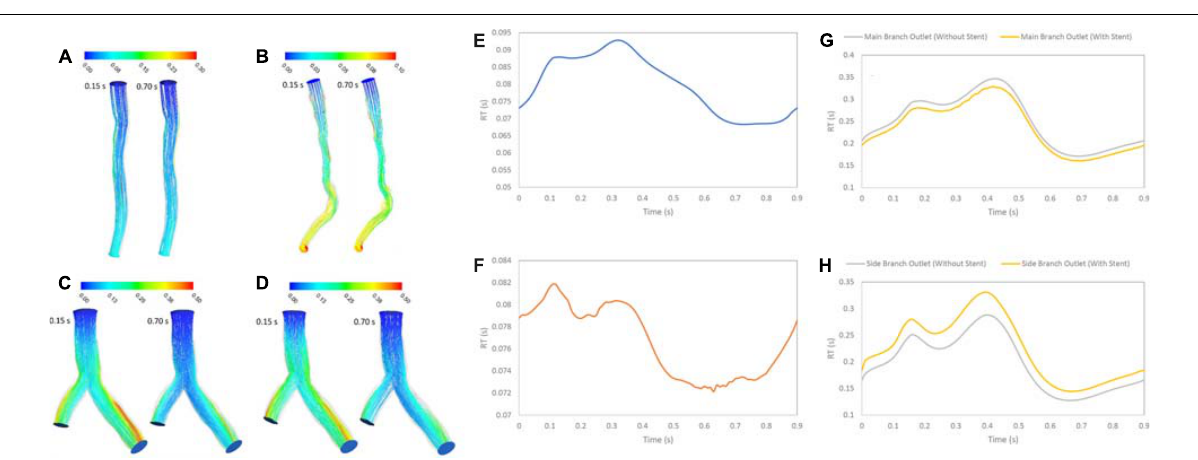
FIGURE 6 | RT pathlines (s) (A) for patient A, (B) for patient B, (C) for patient C without stent, and (D) with stent during both systole (0.15 s of pulse) and diastole (0.7 s of pulse) (E) RT (s) on outlet for patient A, (F) RT (s) on outlet for patient B, (G) RT (s) on main branch outlet for patient C, and (H) RT (s) on side branch outlet for patient C in a cardiac